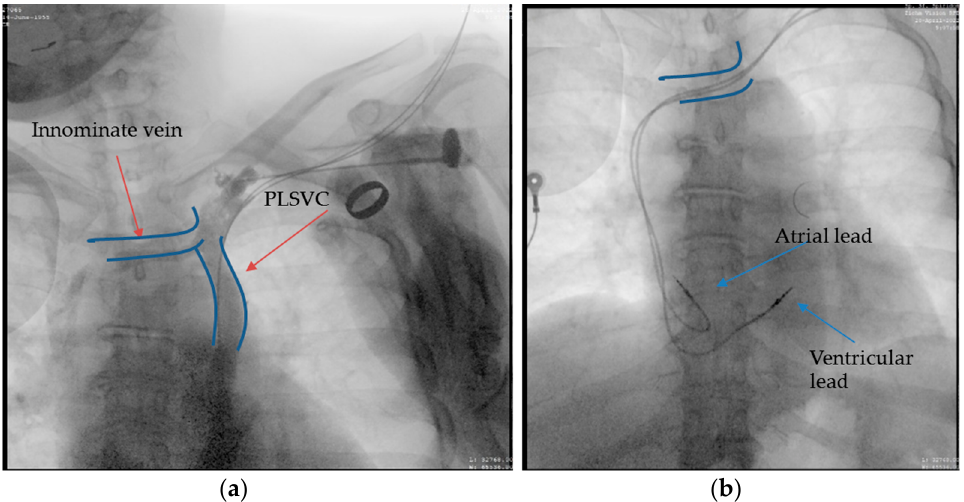
Figure 3. Atrial and ventricular lead placement through innominate vein, right superior vena cava, right atrium, and ventricle: ( a ) the contrast injection in the left subclavian vein showing the presence of PLSVC and innominate vein, which ensures communication with right superior vena cava; ( b ) the final result after we placed the leads at the level of the right atrium (RAA) and right ventricular septum approaching the innominate vein and avoiding the coronary sinus.